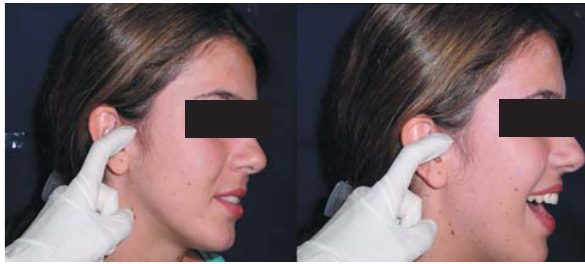
FIGURE 3- Palpation of TMJ’s lateral and posterior